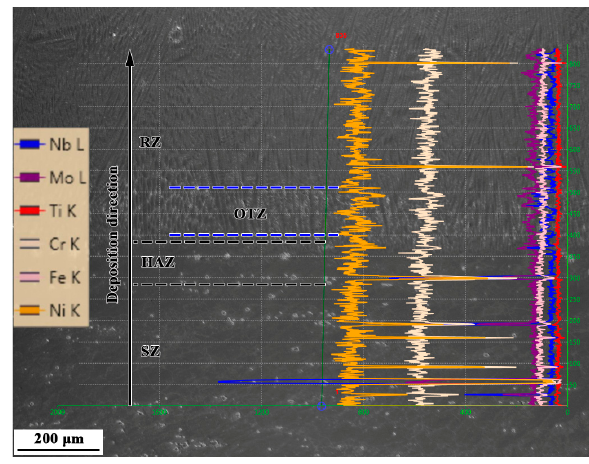
Figure 13. EDS line scanning results of the LARed Inconel 625 alloy sample along the deposition direction.